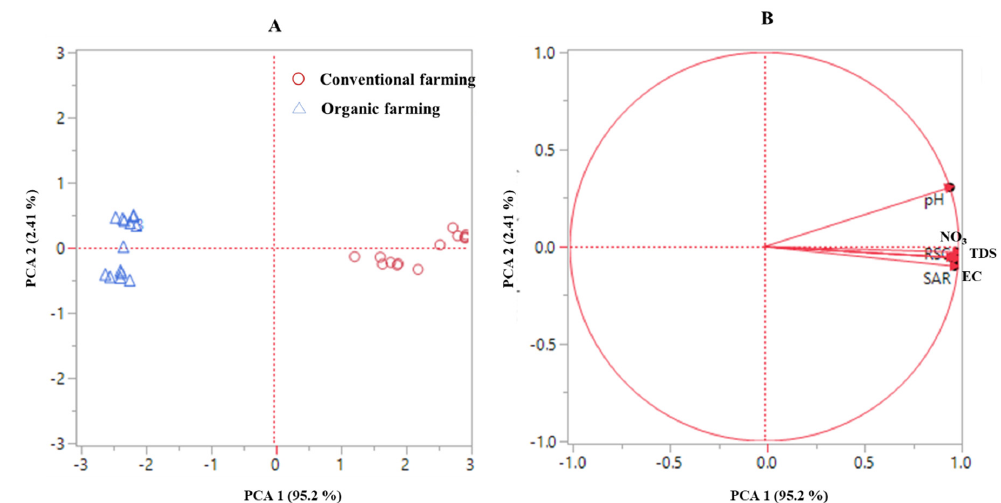
Figure 2. Biplot ( A ) and loading plot ( B ) from the principal component analysis of groundwater quality parameters under organic and conventional rice cultivation systems (n = 42 by combining both years) in Kaithal, Haryana, India. Table 1. Effect of farming practice on groundwater quality parameters under organic and conventional rice cultivation systems (n = 42 by combining both years) in Kaithal, Haryana, India. Farming Practices Parameters F Ratio